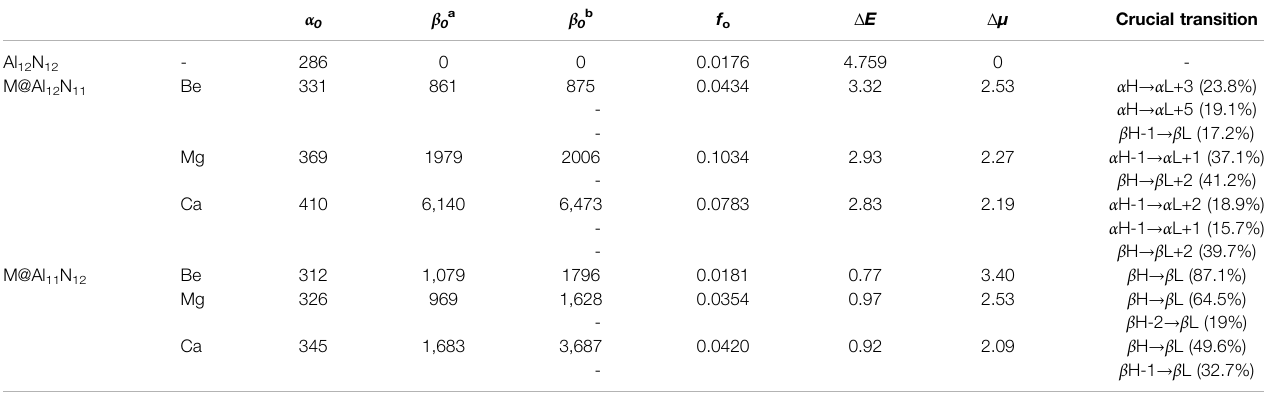
TABLE 2| Staticpolarizability( α 0 ),static fi rst hyperpolarizability β 0 , oscillatorstrength ( f o ),transitionenergy ( Δ E , ineV),and differenceofdipole moment ( Δ μ inD)betweenthe ground and the crucial excited states and crucial transition for M@Al 12 N 11 and M@Al 11 N 12 (M = Be, Mg and